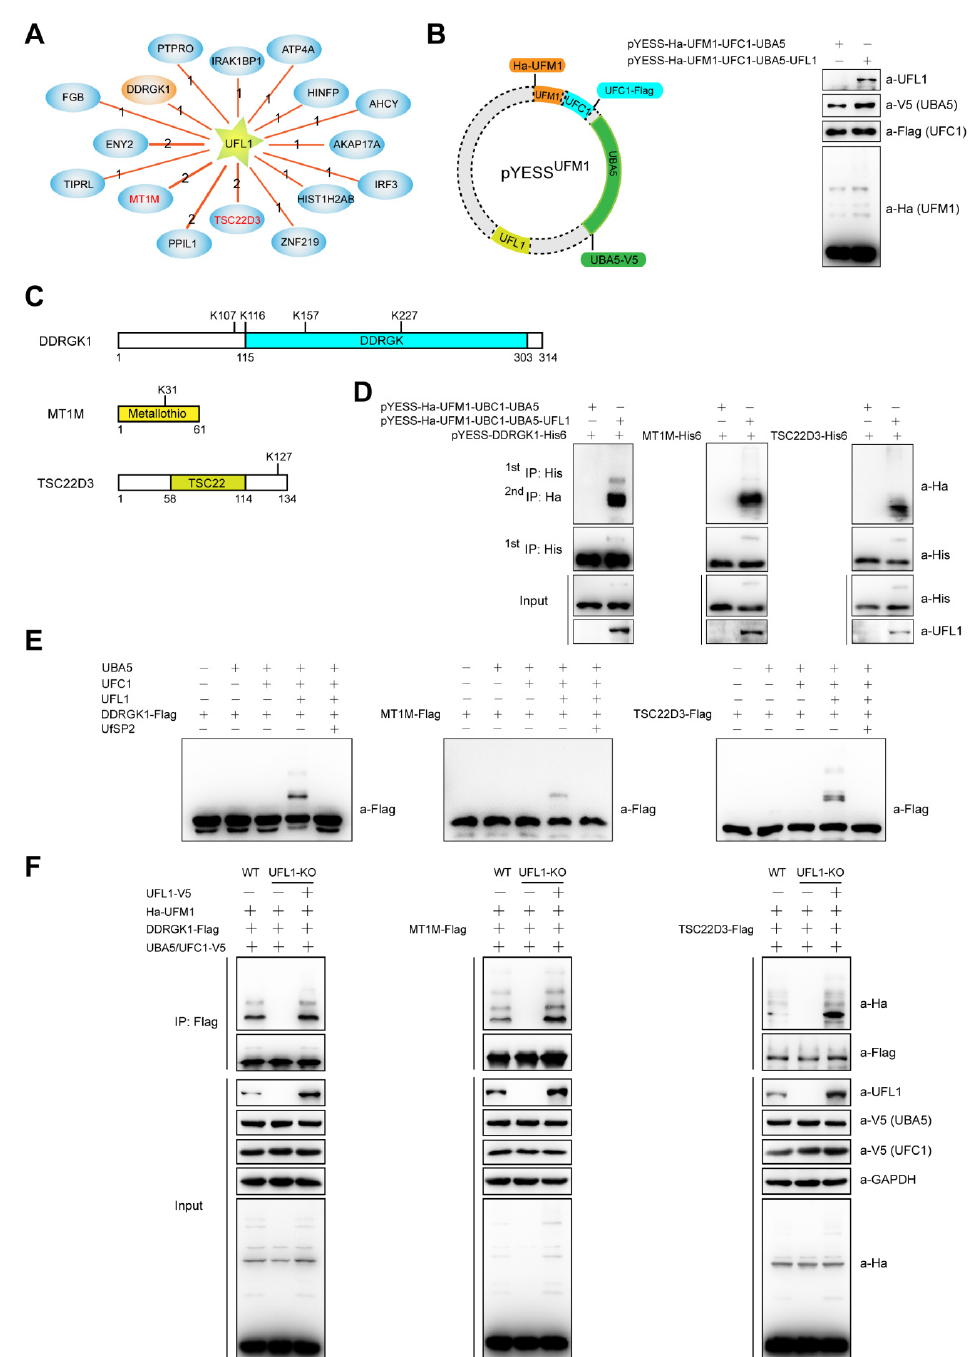
Figure 3. YESS UFM1 , YESS applied to identify and characterize substrates for UFL1-mediated ufmylation. ( A ) UFL1-interacting proteins screened by Y2H with human UFL1 as the bait. ( B ) Reconstituting the E. coli ufmylation system by transforming YESS UFM1 vector that expressing UFM1 (Ha-UFM1), E1 (UBA5-V5), E2 (UFC1-Flag) and E3 (UFL1) into BL21 cells and the expression of these proteins was detected by immunoblotting assay. +, transfected with indicated plasmid; − , without transfected with indicated plasmid. ( C ) A schematic illustration of the ufmylation sites on DDRGK1, MT1M and TSC22D3 identified in E. coli ufmylation system as revealed by mass spectrum analysis. ( D and E ) Substrates validation. UFL1-interacting DDRGK1, MT1M and TSC22D3 were individually subjected to ufmylation assay in E. coli ( D ) or in vitro ( E ). ( F ) Detection the ufmylation of DDRGK1, MT1M and TSC22D3 in wild type or UFL1 − FL HEK293T cells expressing empty vectors or UFL1. − , UFL1 gene knoctout